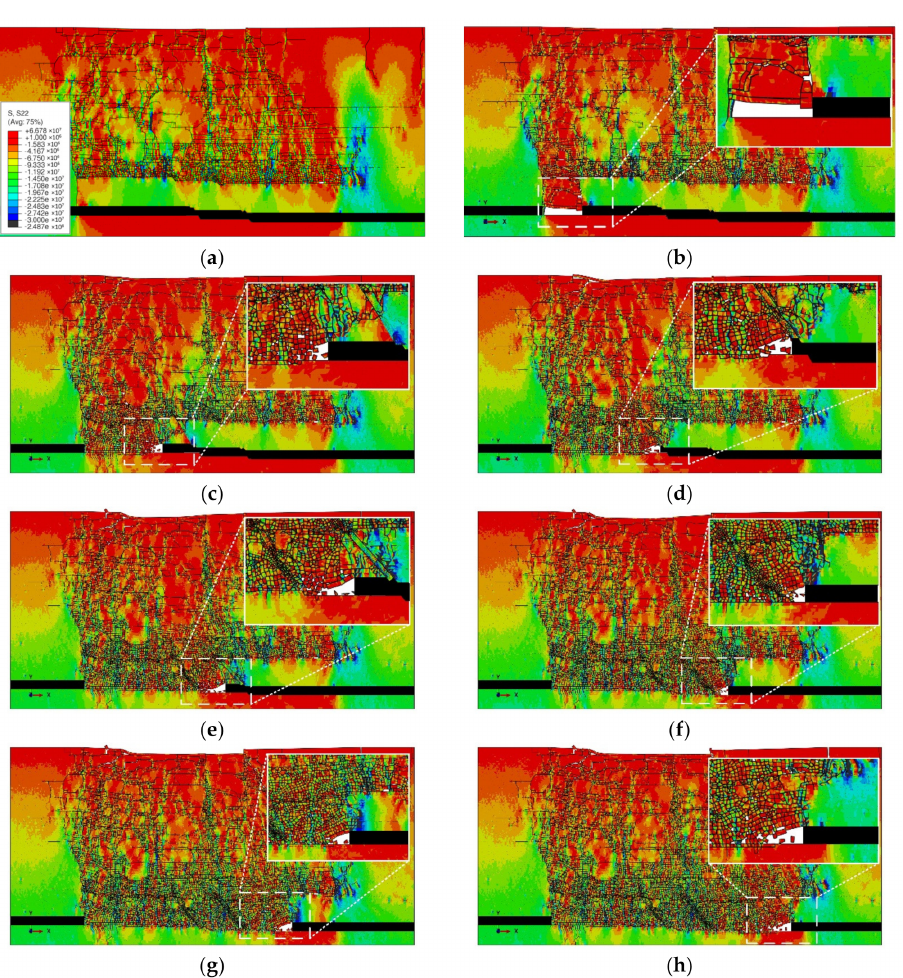
Figure 7. Numerical calculation results of advanced fractures in the roof. ( a ) L = 0 m; ( b ) L = 60 m; ( c ) L = 120 m; ( d ) L = 180 m; ( e ) L = 240 m; ( f ) L = 300 m; ( g ) L = 360 m; ( h ) L = 420